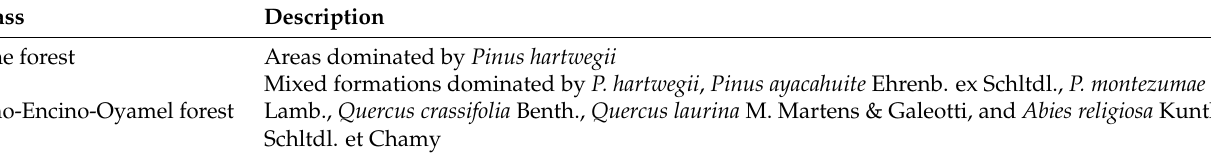
Table 1. Predefined classes were previously defined following Rzedowski (1978) [52] to classify the satellite images. Class Description Pine forest Areas dominated by Pinus hartwegii Mixed formations dominated by P. hartwegii , Pinus ayacahuite Ehrenb. ex Schltdl., P. Pino-Encino-Oyamel forest